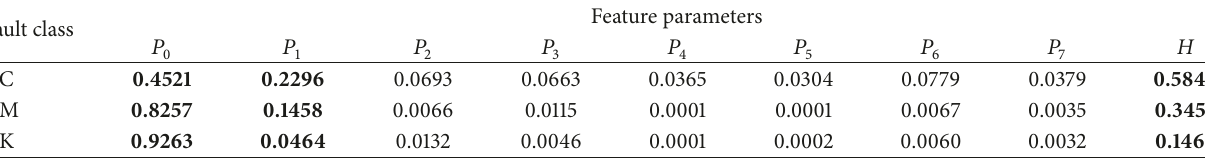
Table 3: The wavelet packet energy entropy features.